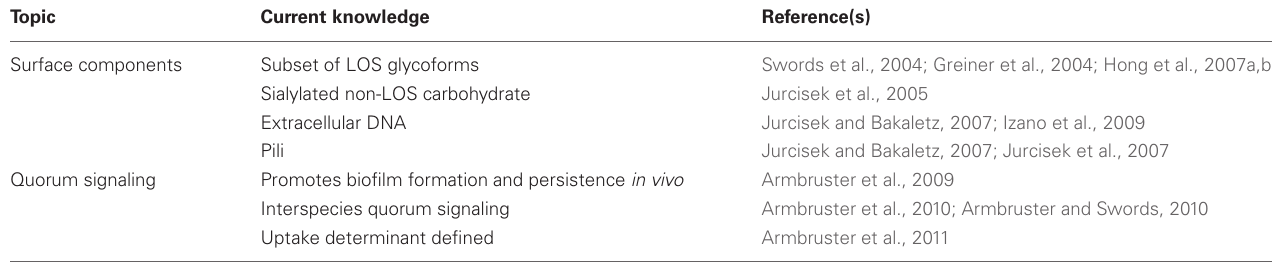
Table 2 | Summary of current knowledge about determinants of H. influenzae biofilm formation.